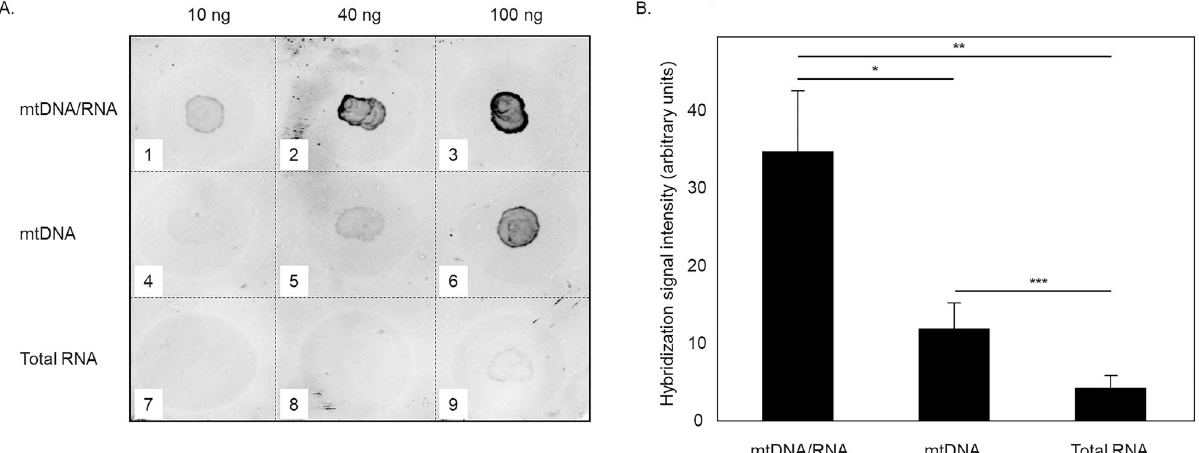
Figure 3. Mitochondria is the primary site of DNA/RNA oxidative damage. ( A ) Dot blot hybridization of retinal mtDNA/RNA, mtDNA (mtDNA/RNA treated with RNAse) and total RNA with antibodies against 8OHdG/8OHG. ( B ) Densitometry analysis of the dot blot hybridization indicates that the mtDNA/RNA are subjected to oxidative modification: RNA from mitochondria contributes ~ 65% to the hybridization signal and remaining 35% comes from mtDNA. mtDNA/RNA and total RNA were isolated from eight C57BL/6 control mouse retinas. Three independent hybridizations were performed. * P = 0.001, ** P = 0.003 and *** P = 0.03. Data are presented as the mean ±